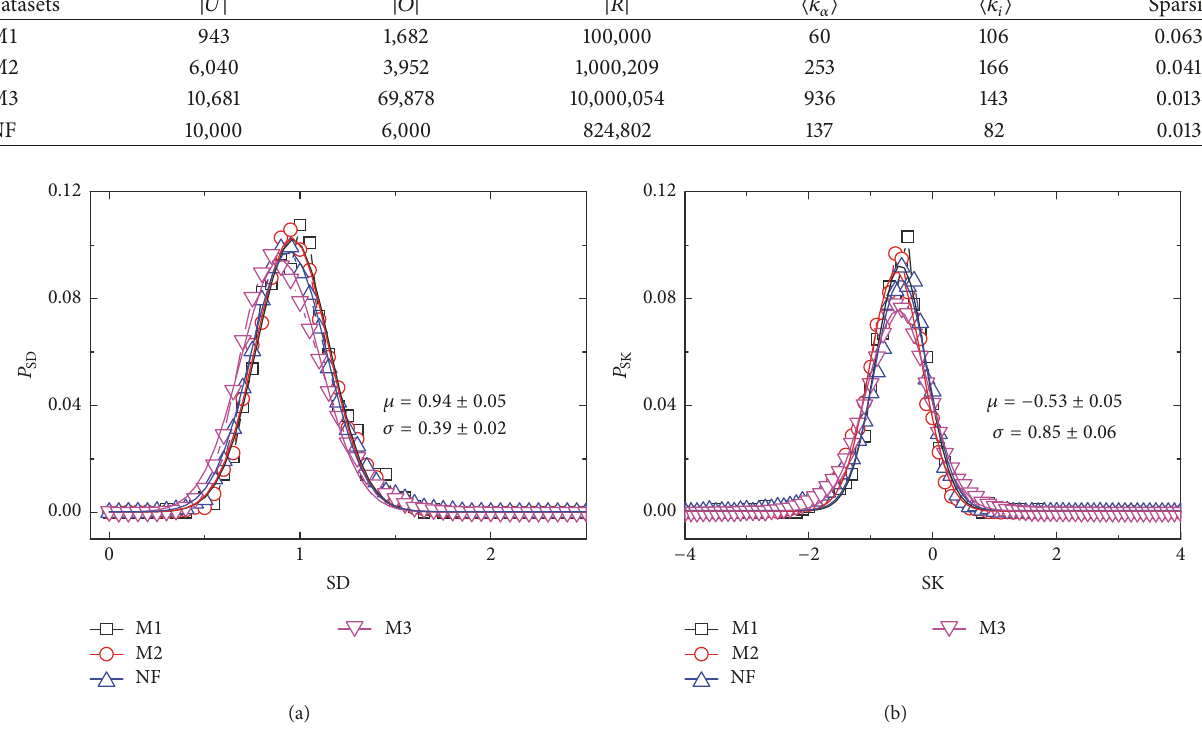
Table 1: The statistical features of the four real datasets . |𝑈| , |𝑂| , and |𝑅| are the number of users, objects, and rating records (i.e., the number of edges of bipartite networks), respectively. ⟨𝑘 𝛼 ⟩ and ⟨𝑘 𝑖 ⟩ are the average degree of objects and users, respectively.